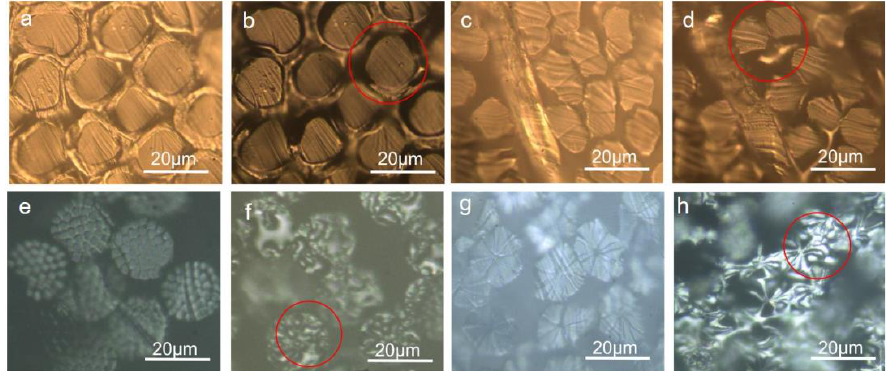
Figure 3. Before and after in-situ melting of core-shell, side-by-side, fibril matrix, and lobe bicom- ponent fibers. Magnification: 2400, ( a , b ) before and after melting of the PE/PP core-sheath